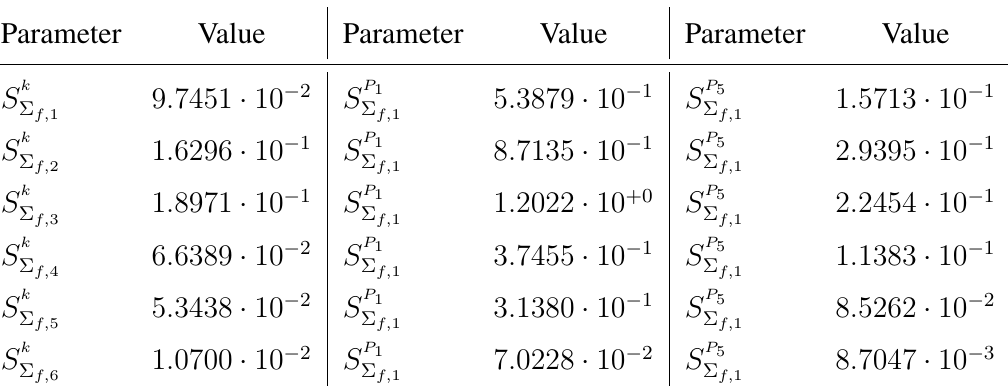
and power in a 1